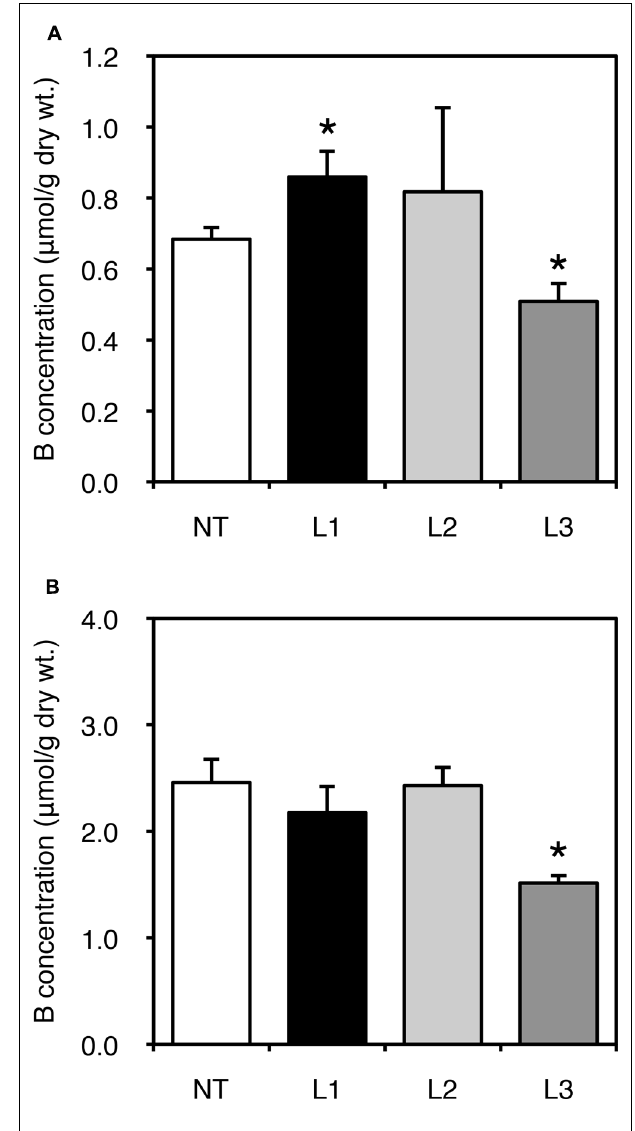
FIGURE 4 | Fruit B concentrations in transgenic tomato plants expressing AtBOR1 under B-deficiency and sufficiency. Non-transgenic (NT) and transgenic (L1, L2, and L3) plants were grown in a hydroponic solution supplied with 0.1 or 100 μ M boric acid until fruit setting. Fruits were harvested from plants grown under 0.1 μ M (A) or 100 μ M (B) B treatment. B concentrations in the fruits were measured using ICP-MS. Values represent the means ± standard deviation ( n = 3–4). An asterisk indicates significant differences from the non-transgenic plants (Student’s t -test, p <